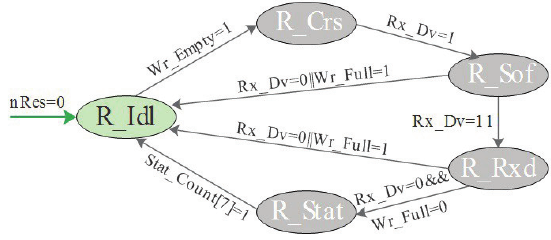
Fig. 5. State Automata in Tx Block.